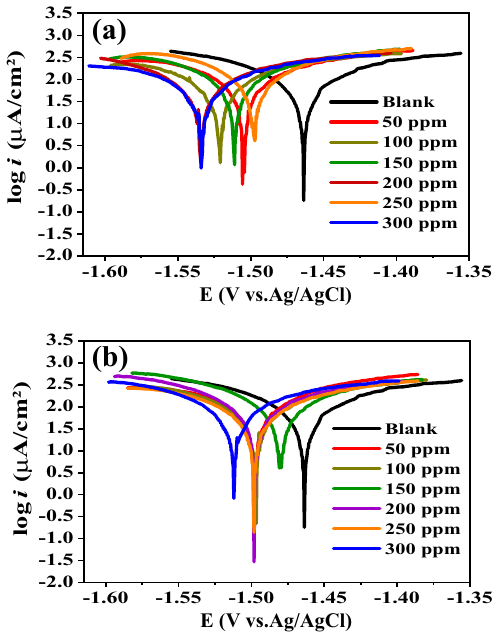
Figure 4. Potentiodynamic polarization curves of Al in 0.1 M NaOH solution containing different concentrations of ( a ) Cefx and ( b ) Cefz at 293 K.